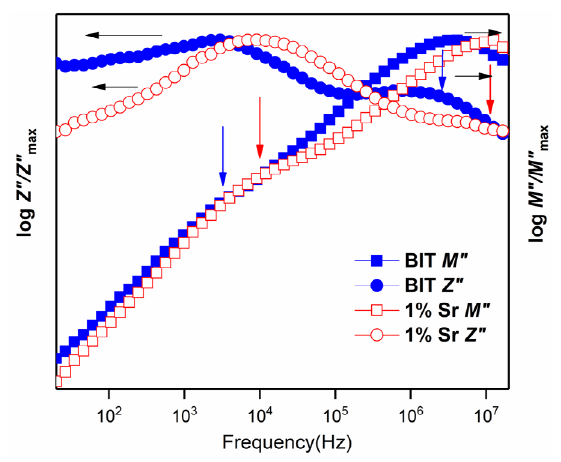
Fig. 5 Frequency dependence of and log / Z Z   of BIT and 1%Sr samples at 450 ℃ . max M  max